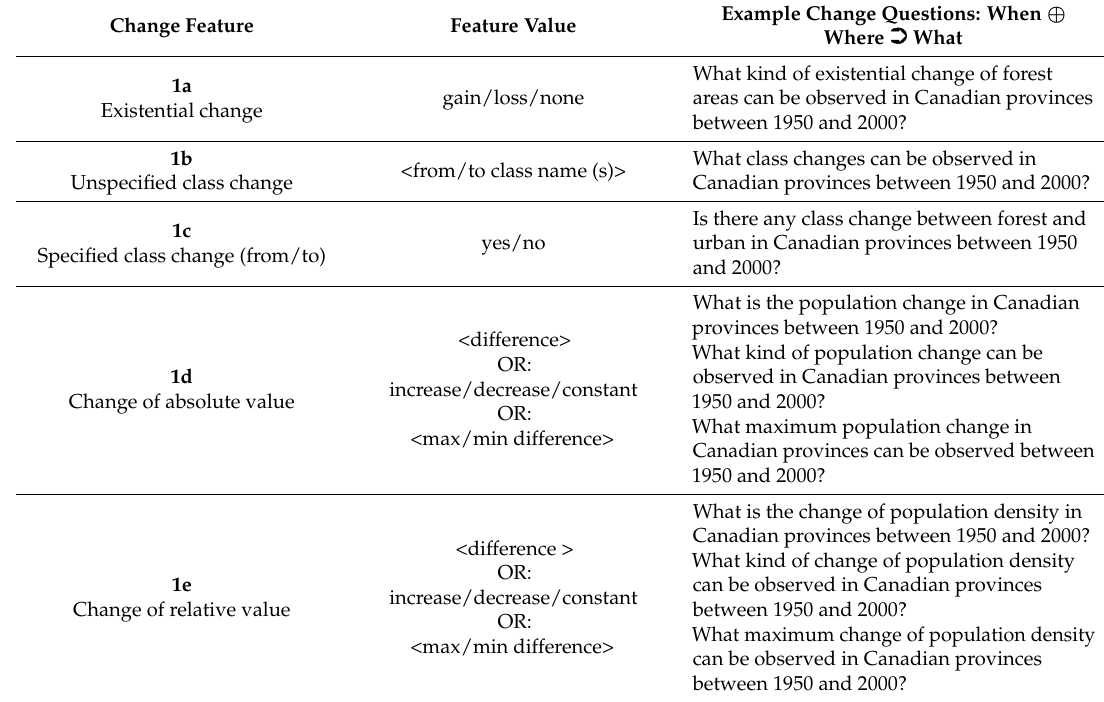
Table 1. Characteristics of “What” output clauses.